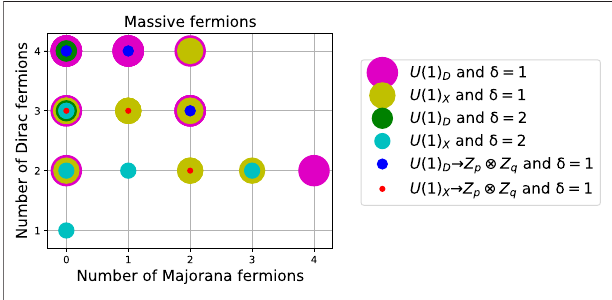
FIGURE 2 | Number of massive Dirac and Majorana fermions of the full set of solutions in Figure 1 . The discs magenta and green (yellow and cyan) are for dark(active) symmetries which allows the effective Dirac neutrinomass operator for at least two right-handed neutrinos for d = 4 + δ , with δ = 1, two respectively. Similarly, the blue and red points are the type of solution which satisfy the unconditional stability conditions for at least two DM candidates.